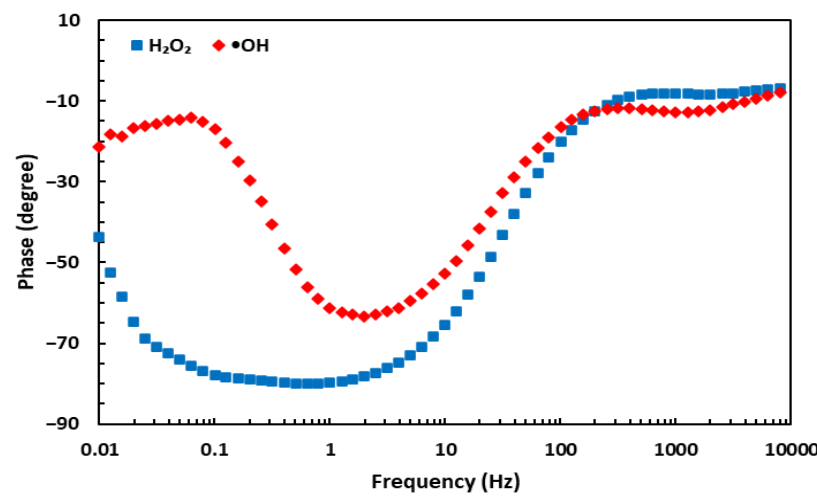
Figure 7. Bode plots for phase angle shifts for the EIS results obtained with the GSH-modified electrode in the presence of • OH and H 2 O 2 .